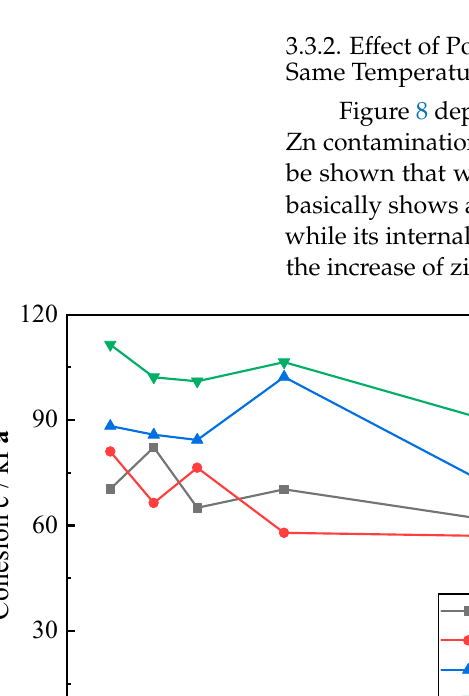
Figure 7. Curve of influence of temperature on the shear strength index of red clay. ( a ) The graph of the change of cohesion force with temperature; ( b ) The graph of internal friction angle with tem- perature